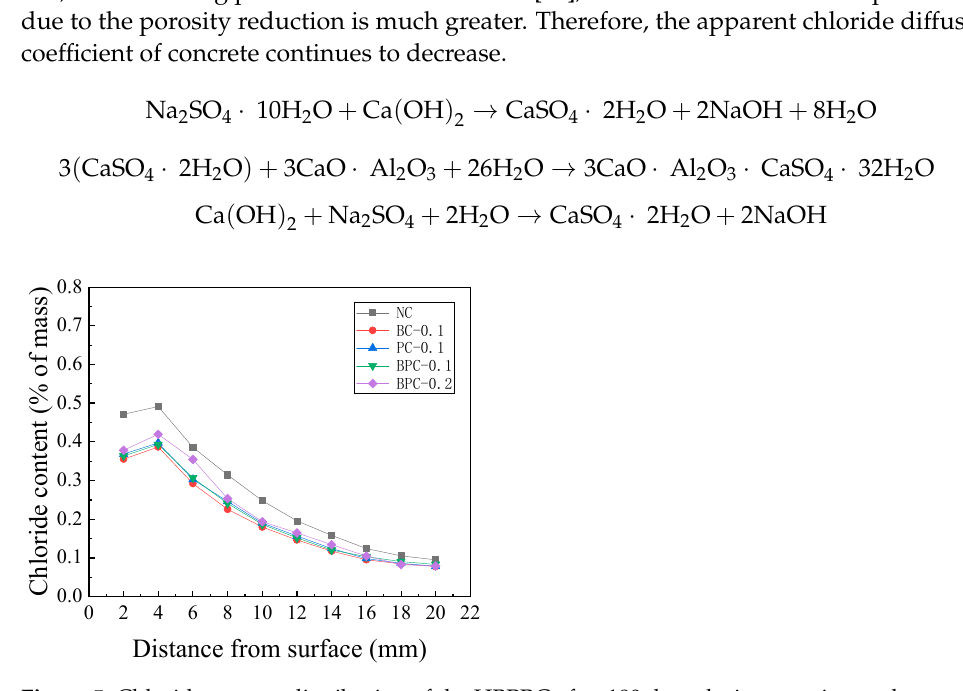
Figure 5. Chloride content distribution of the HBPRC after 180 days drying–wetting cycles. Figure 6 indicates that the apparent chloride diffusion coefficient of specimen NC shows an upward trend after 120 days of erosion. This may be caused by cracking due to the corrosion products, as the expansive ettringite and gypsum generate local expansion stress on the walls of the pores. When the stress exceeds the tensile strength of the con- crete matrix, microcracks form and gradually develop into macrocracks. Compared with the filling effect of the hydration products and corrosion products on the pores, the ac- celerating effect of cracks on chloride penetration is more significant. Thus, the apparent chloride diffusion coefficient of specimen NC increased during the late stage of erosion. This agrees well with Jin’s study [43], whose result also indicated that sulphate decreased the chloride penetration rate in the short term but increased it in the long term. However, the apparent chloride diffusion coefficient of the specimens with fibres continued to de- crease after 120 days of erosion. This is because the fibre can effectively prevent the for- mation and development of sulphate corrosion microcracks, thus reducing the accelera- tion effect of sulphate corrosion microcracks on chloride penetration at the late stage of erosion. Specimen BPC-0.1 exhibited the lowest apparent chloride diffusion coefficient after 180 days of erosion, which was 43.1% lower than that of specimen NC. Although the variability in the experimental results cannot be excluded, these results are also ex- plainable. According to El-Hamrawy’s study, PF with a low elastic modulus can bridge microcracks and delay the development of microcracks into macrocracks, while BF with a high elastic modulus can inhibit the expansion of macrocracks [7]. As a result, BF and PF form a complex fibre network, which can prevent the formation and development of sulphate attack microcracks more effectively than BF or PF alone. From Figure 6 and the above analysis, it can be found that the relationship between chloride diffusion coefficient and erosion time of each group of specimens can be ap- proximately described by quadratic polynomial function, namely D = A + B t + C t 2 , where t is the erosion time (days); A, B, and C are material property parameters determined from tests. It is obvious that the larger A is, the worse the concrete’s resistance to chlo- ride attack at the early stages of erosion; the smaller B and the larger C are, the earlier sulphate attack begins to have an adverse effect on the chloride attack resistance of con- crete. The regression analysis is carried out according to the experimental data, and the results are shown in Table 5. Table 5 indicates that there is a good correlation between the chloride diffusion coefficient and erosion time for all groups of specimens, with cor- relation coefficients exceeding 0.96. Specimen BC-0.1 had the smallest A. In addition, the incorporation of fibres increased B and decreased C, and specimen BPC-0.1 had the largest B and the smallest C, which increased by 8.99% and decreased by 18.16%, respec- tively, compared to specimen NC. This indicates that the 0.1% hybrid BF–PF was the most effective in inhibiting sulphate erosion, which is consistent with the results of the above analysis.